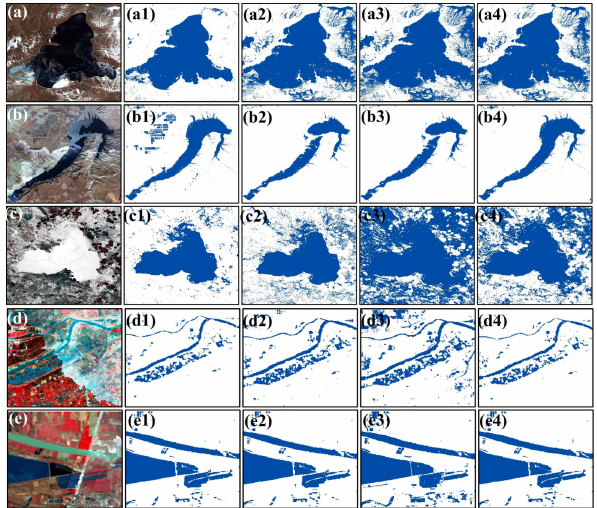
Figure 5. Comparisons between our method (a1-e1) and other